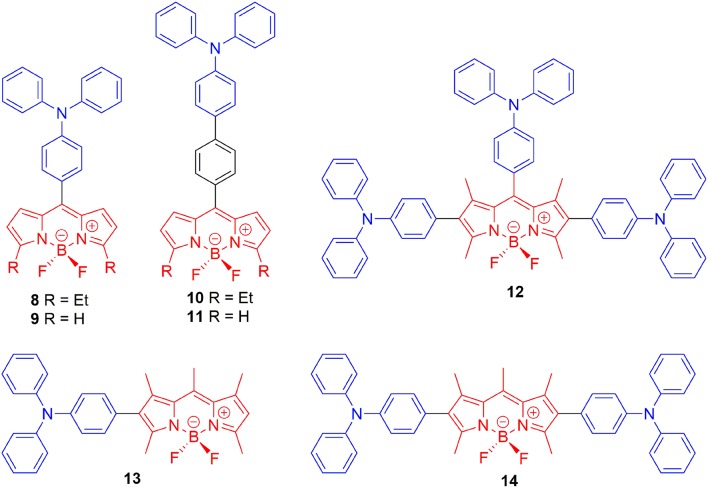
Chemical structures of compounds 8–14.